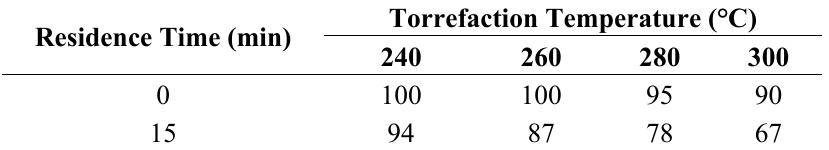
Table 3. Influence of heating time on the mass yield (wt%) for different torrefaction temperature. Residence Time